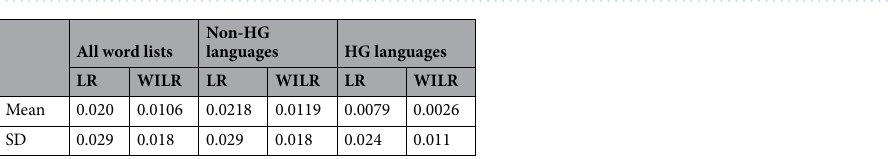
Table 1. Average LR and WILR values for 2729 ASJP word lists used in the main analysis.